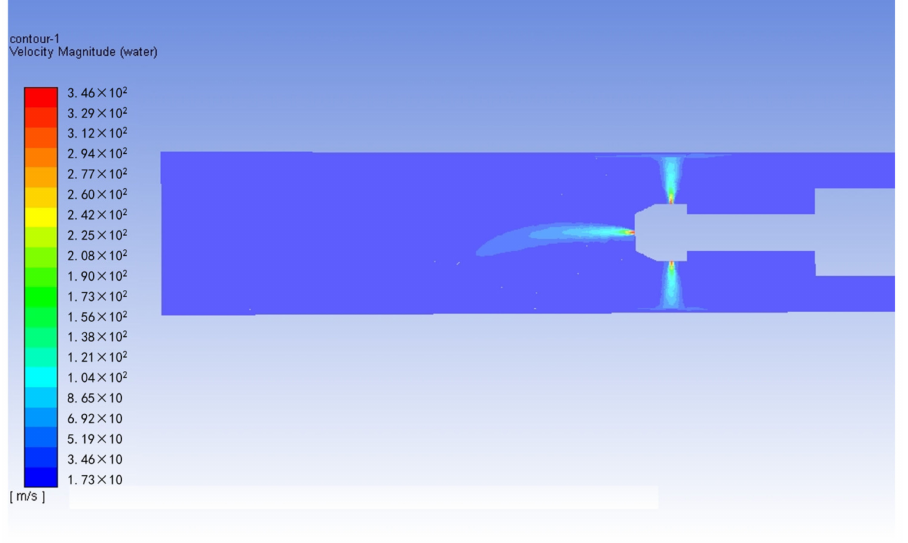
Figure 13. Schematic diagram of rotary jet’s flushing effect.